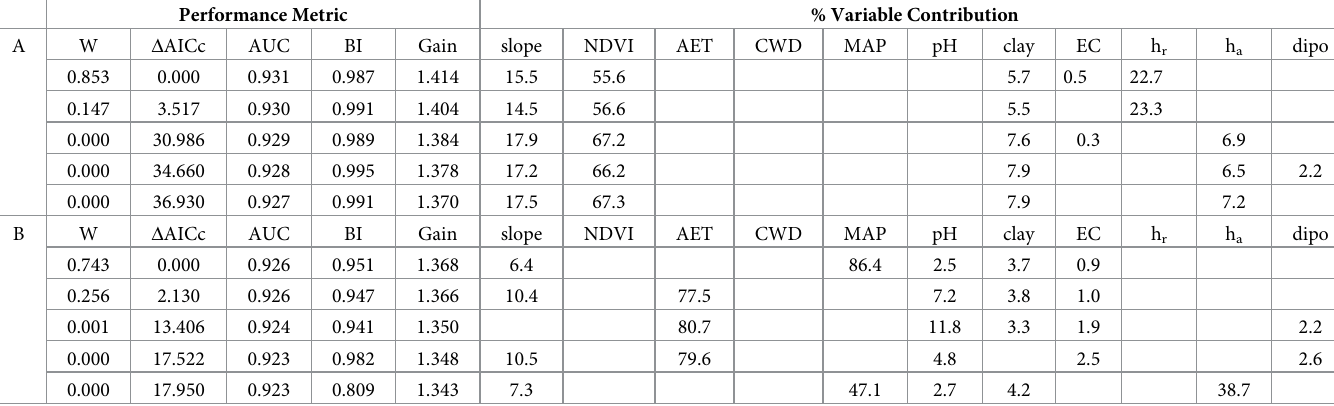
Table 1. Performance metrics and variable contribution of top performing habitat suitability models. Performance